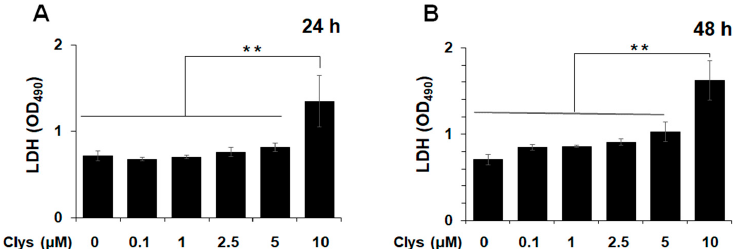
Figure 2. Cell cytotoxicity of Candidalysin (Clys) to human gingival fibroblasts (HGFs). After HGFs were treated with Clys (0.1, 1, 2.5, 5, 10 μ M) for ( A ) 24 h and ( B ) 48 h, the cell cytotoxicity was determined by lactate dehydrogenase (LDH) assay. Values of ** p < 0.01 was considered to indicate statistical significance (one-way analysis of variance with a post-hoc Tukey’s test).